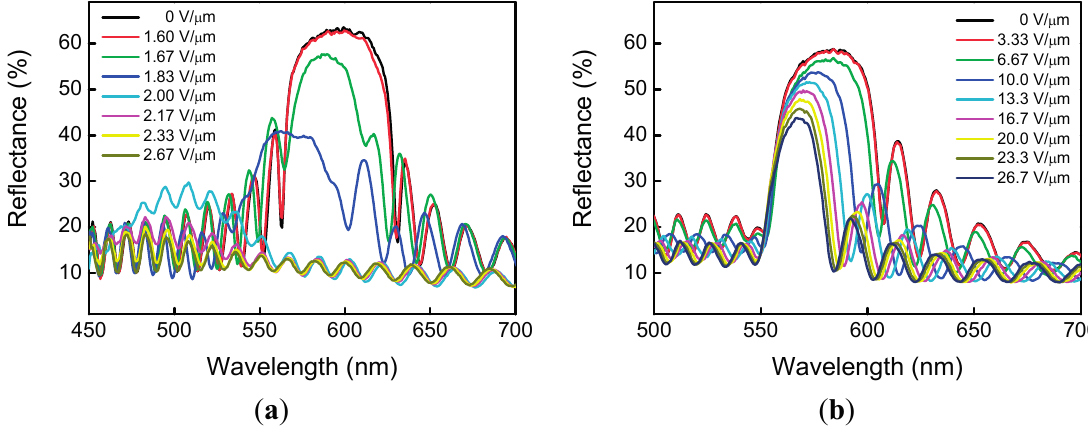
Figure 1. Electro-optic characteristics of the polymer/ChLC nano-composite with 8 wt % chiral dopant concentration ( a ) before polymerization and ( b ) after